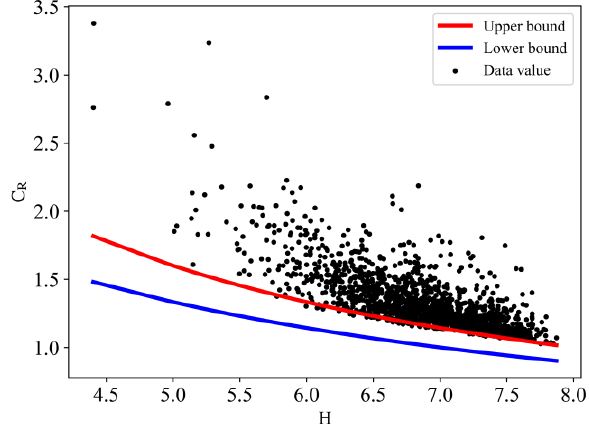
Figure 12. Distribution plot of C R obtained by